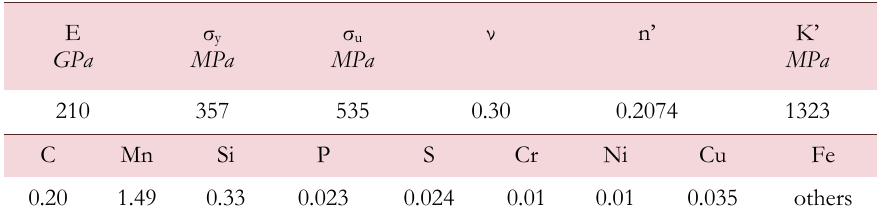
Table 1: Strength properties and chemical composition (%) of S355J0